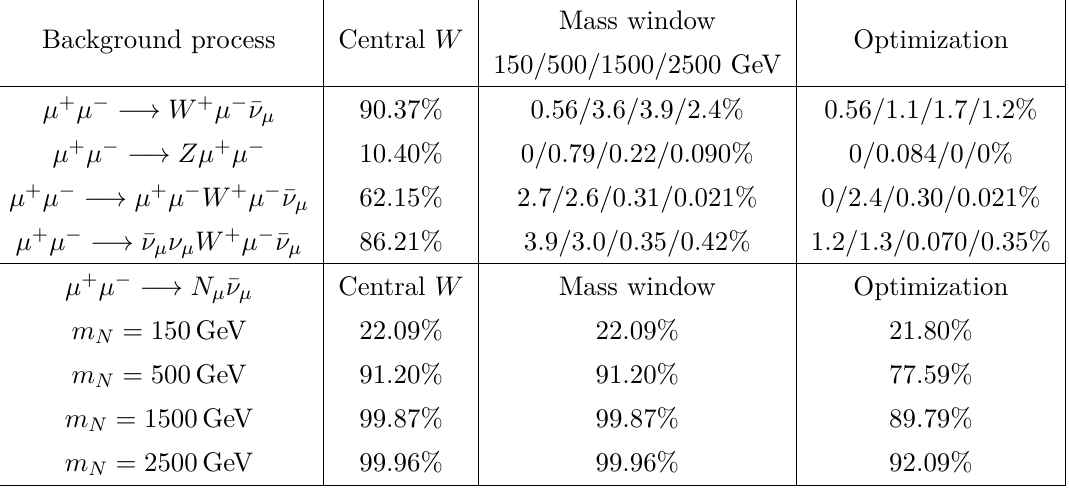
Table 14 . Cutflow table for N µ at 3 TeV. All processes after pre-selection is set to 100%.